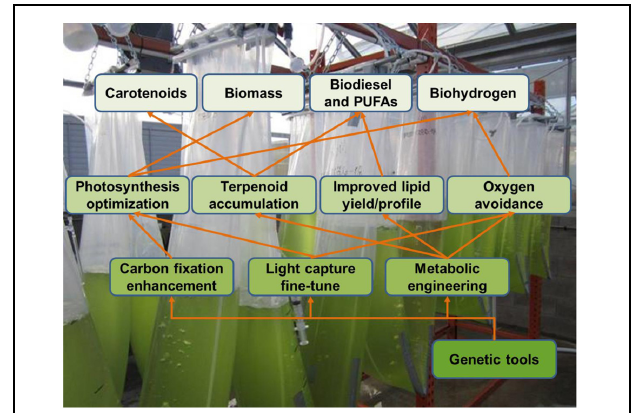
FIGURE 4 | Contribution of microalgal genetic tools to enhance the production of secondary metabolites and